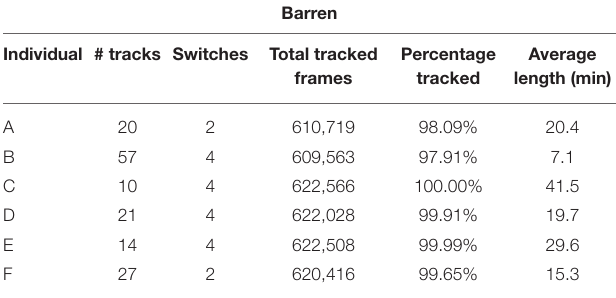
TABLE 2 | Tracking summary per individual in barren environment.